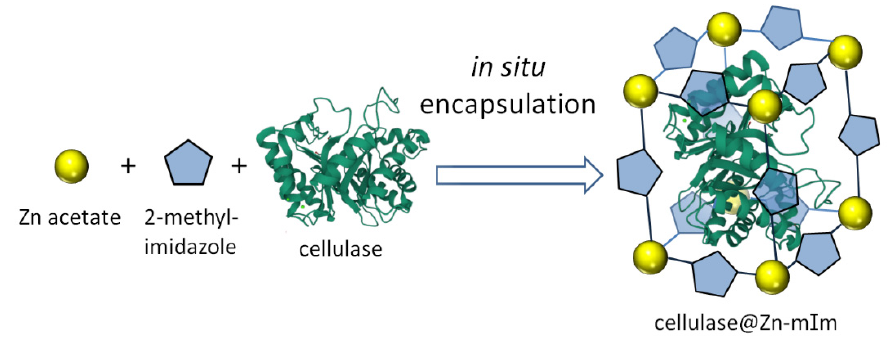
Figure 2. Formation of Zn-containing MOFs with encapsulated cellulase. Formation of nanogel in the presence of cellulase by direct cross-linking of poly( N - vinylpyrrolidone- co - N -methacryloxysuccinimide) with an enhanced green fluorescent protein allows successful encapsulation of the enzyme [60]. Self-assembly of chitosan around cellulase by salting out from a mixed solution allowed for the formation of nano- hybrid which was deposited on alginate beads [49]. The nanobiocatalyst showed in- creased stability and efficiency in hydrolysis of sugarcane bagasse. The most important advantage of encapsulation is robustness, although possible shortcomings, such as accompanied adsorption and a loss of conformation integrity could minimize its appeal. In addition, similar to the physical adsorption, cellulase encapsula- tion is only favorable, if the access to the enzyme in the nanomaterial is not impeded. 2.3. Covalent Attachment Covalent attachment is frequently favored for cellulase immobilization because it provides enhanced stability which is often combined with improved activity of the en- zyme—important advantages of this approach. Covalent immobilization, however, re- quires functionalization of the support unless the support inherently possesses functional groups [50,61–63]. In addition, a suitable linker is needed to preserve the enzyme confor- mation [9,64]. The most commonly used bifunctional linker is glutaraldehyde which in- teracts with amino groups at ambient conditions and does not require any catalyst [9,24,64,65]. Despite the length of glutaraldehyde is only 0.75 nm [66], it apparently pro- vides a sufficient distance to prevent non-specific adsorption of the enzyme. Longer link- ers, such as tetradecanedioic and docosanedioic dicarboxylic acids with approximate ex- tended chain lengths of 1.4 and 2.2 nm, respectively, were also explored [67], however, the interaction of carboxyl group terminal linkers with amino functionalized supports (formation of a peptide bond) is less than favorable, requiring elevated temperatures or/and a catalyst [68,69]. In the case of supports with carboxyl groups on the surface (for example graphene oxide, GO), first acids are activated with carbodiimide (for example, 1-ethyl-3-(3-